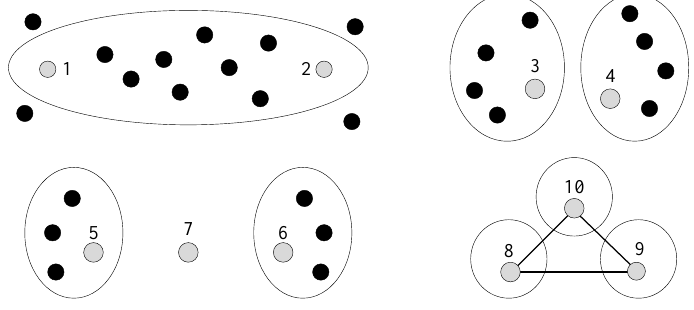
Figure 1. Which question should the machine ask? Large circles are